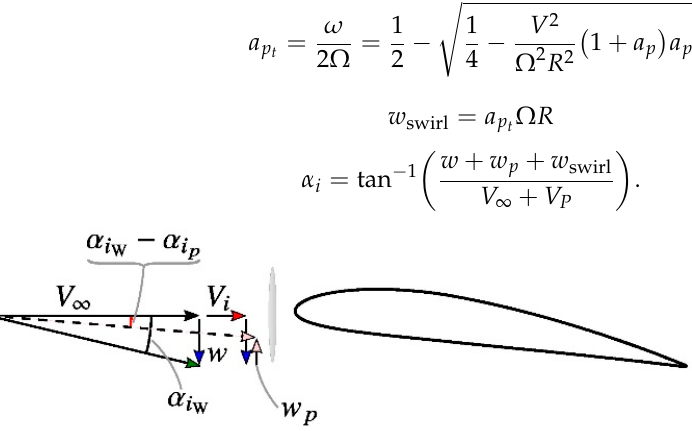
Figure 18. Induced angles due to wing and rotating